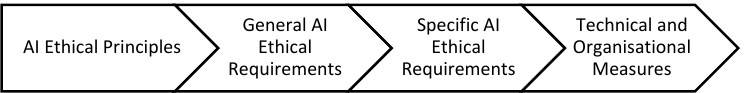
Figure 1. Steps for operationalizing AI ethical